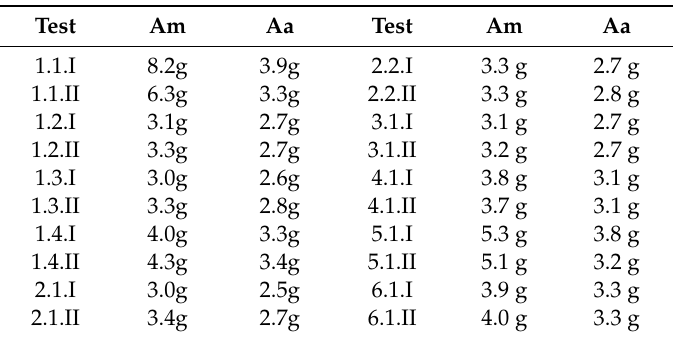
Table 11. Maximum and Average Acceleration.